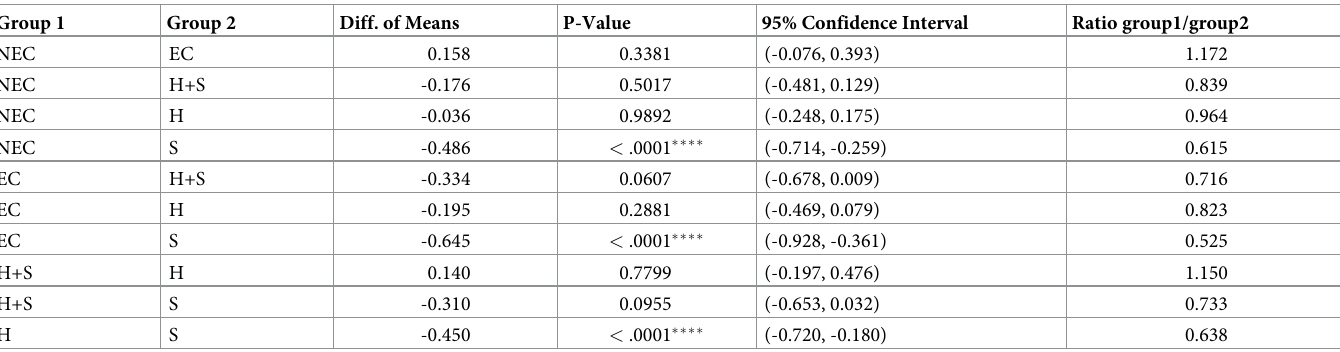
Table 4. Pairwise Tukey’s Post-hoc of log TFF3 levels in cohort groups, sexes pooled. Group